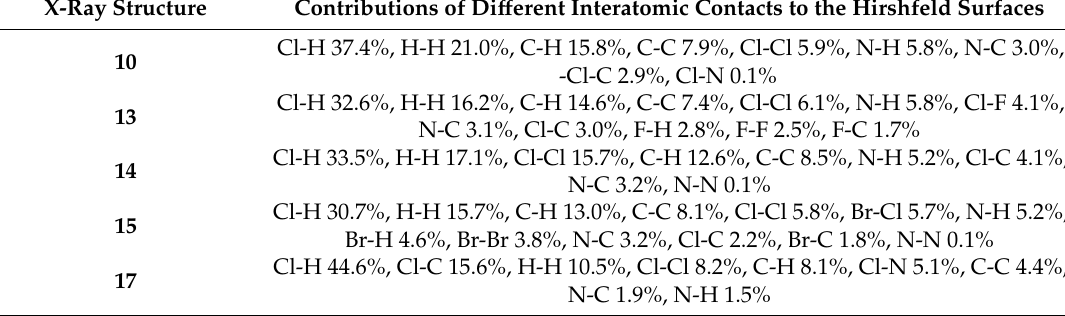
Table 2. Main partial contributions of di ff erent interatomic contacts to the Hirshfeld surfaces of X-ray structures 10 , 13 – 15 , and 17